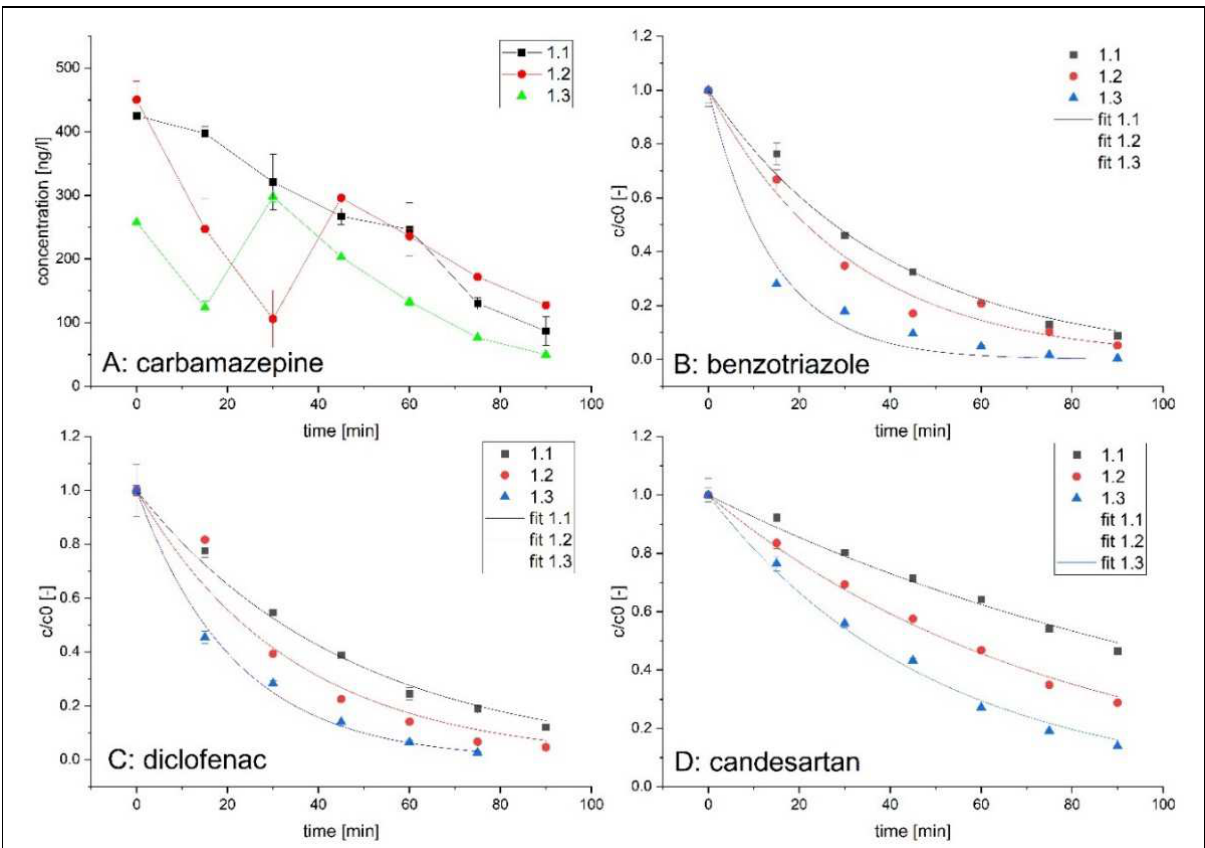
Figure 4. Concentration curves of carbamazepine and concentration curves and first-order fitting curves for benzotriazole, diclofenac, and candesartan for batch reactor experiments.